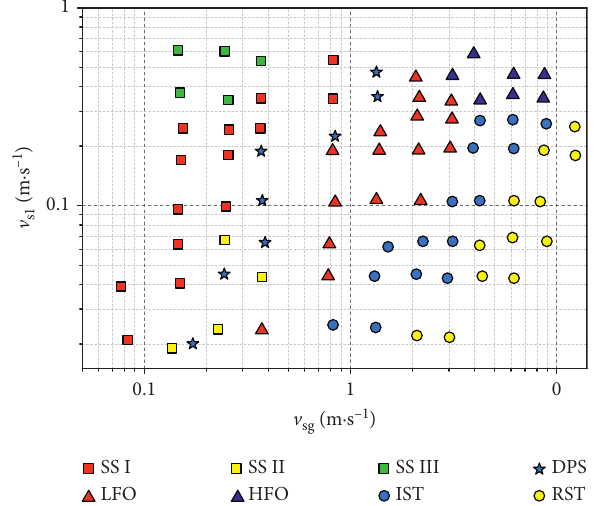
Figure 11: Gas-liquid flow pattern in a hilly-terrain pipeline-riser system (SS: severe slugging; DPS: dual-peak slug; LFO: low-fre- quency oscillation; HFO: high-frequency oscillation; IST: irregular- stable flow; and RST: regular-stable